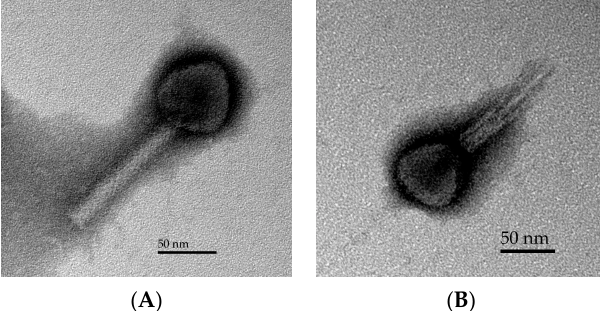
Figure 1. Transmission electron micrograph of phage ST32 with uncontracted ( A ) and contracted ( B ) ( B ) tails.